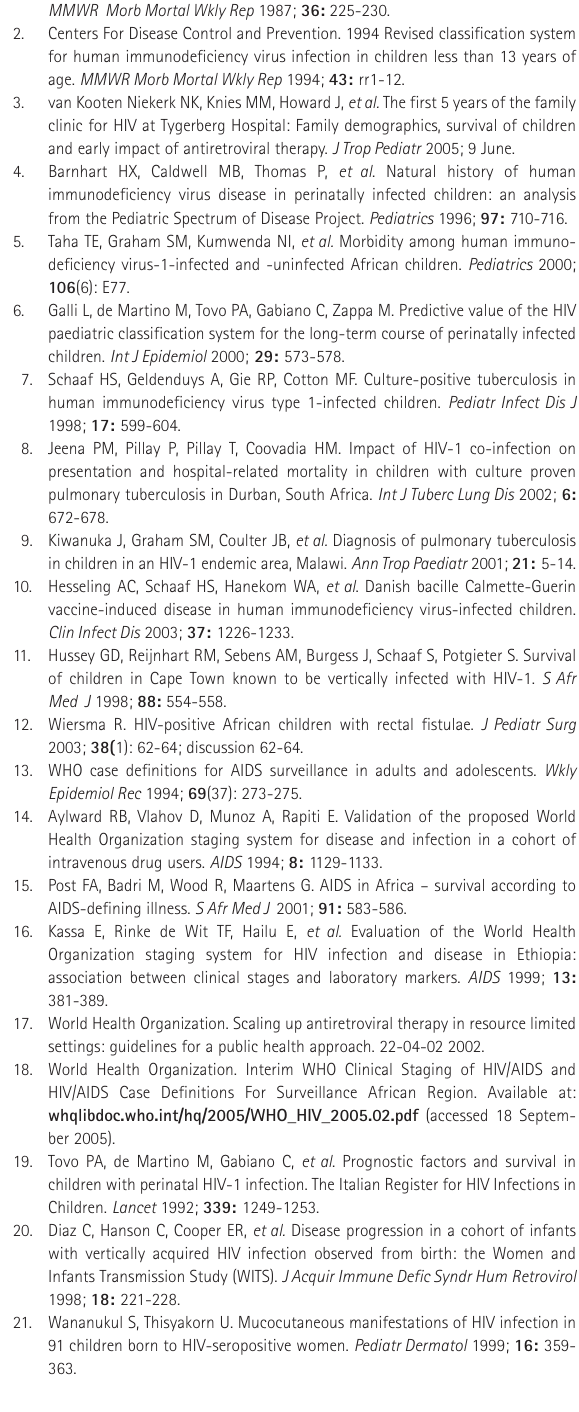
TABLE III. PRESUMPTIVE STAGE 4 HIV INFECTION IN INFANTS BELOW 18 MONTHS OF AGE